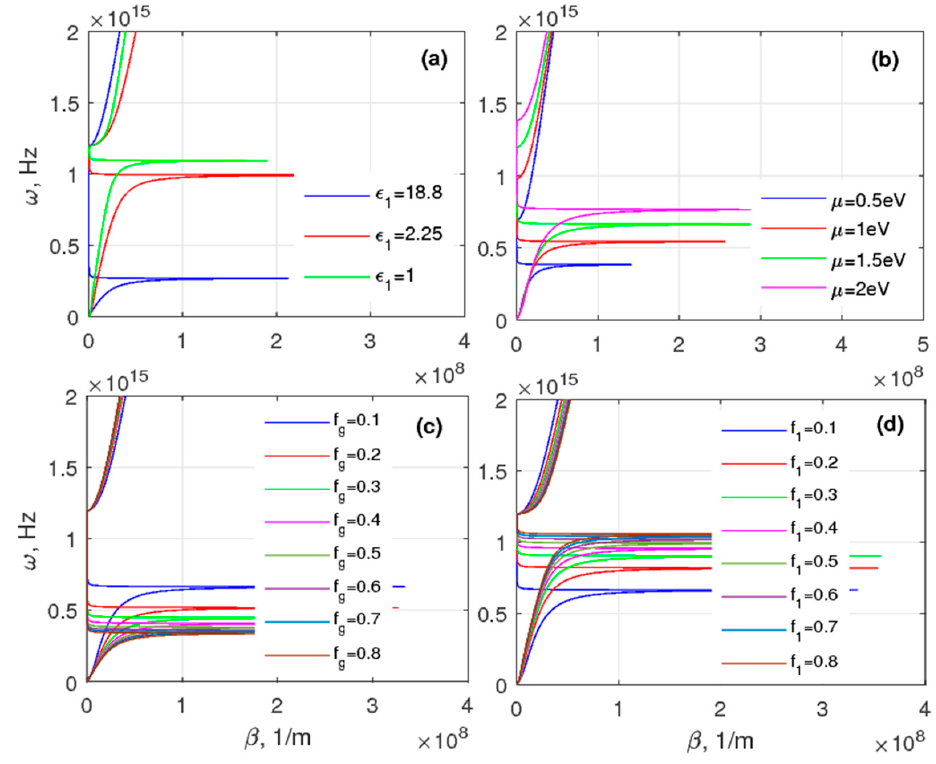
Figure 8. The impact of ( a ) ε 1 , ( b ) Fermi energy µ , ( c ) graphene filling ratio, f g , and ( d ) dielectric filling ratio f 1 on the dispersion diagrams of the SPPs. f g = 0.1, f a = 0.5 in ( a ). f g = 0.1, f a = 0.1 in ( b ). µ = 1.5 eV in ( a , c , d ).